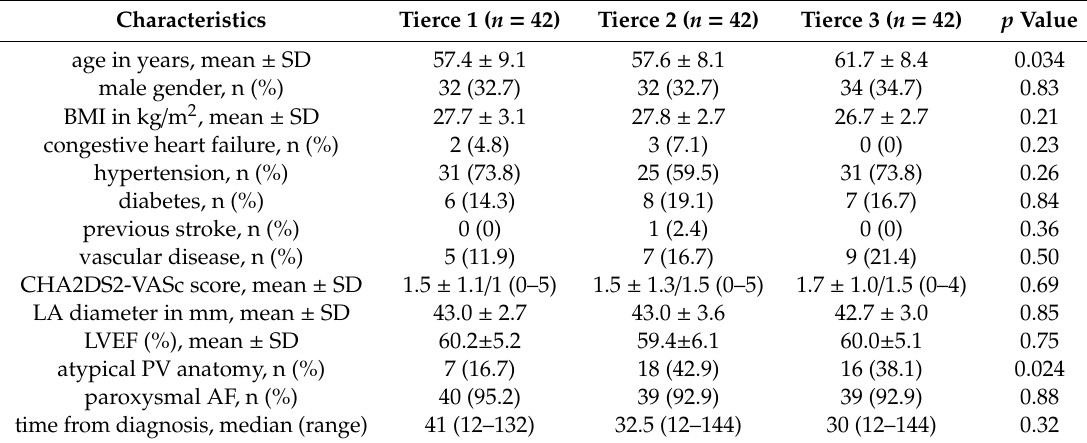
Table 1. Baseline characteristics of the